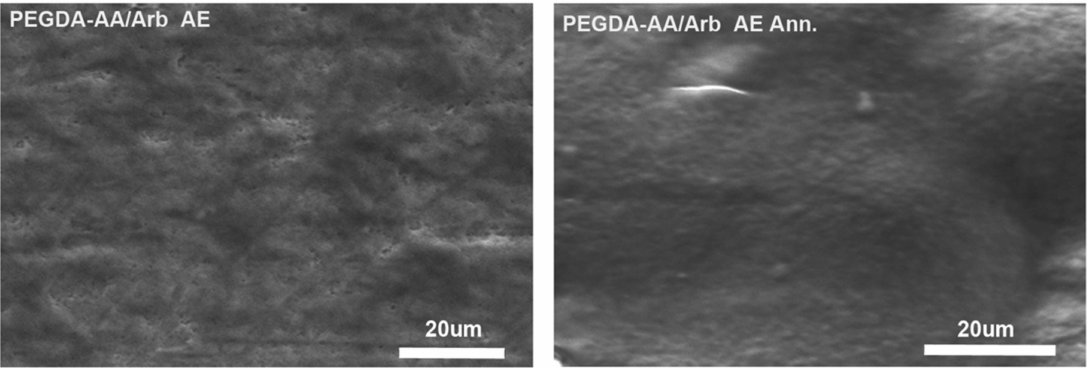
Figure 4. SEM morphological analyses of PEGCA-AA / Arb AE, as prepared ( on the left ) and after annealing ( on the right ).